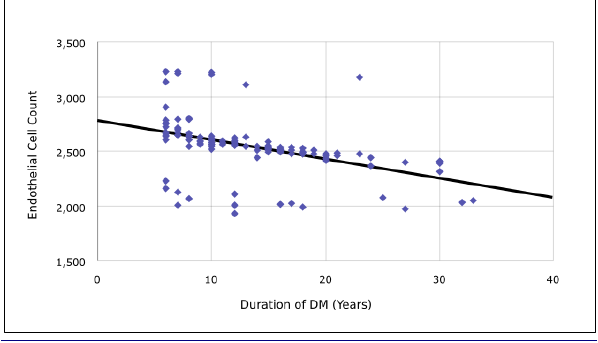
Table 2 : Comparison of endothelial cell count between cases and controls